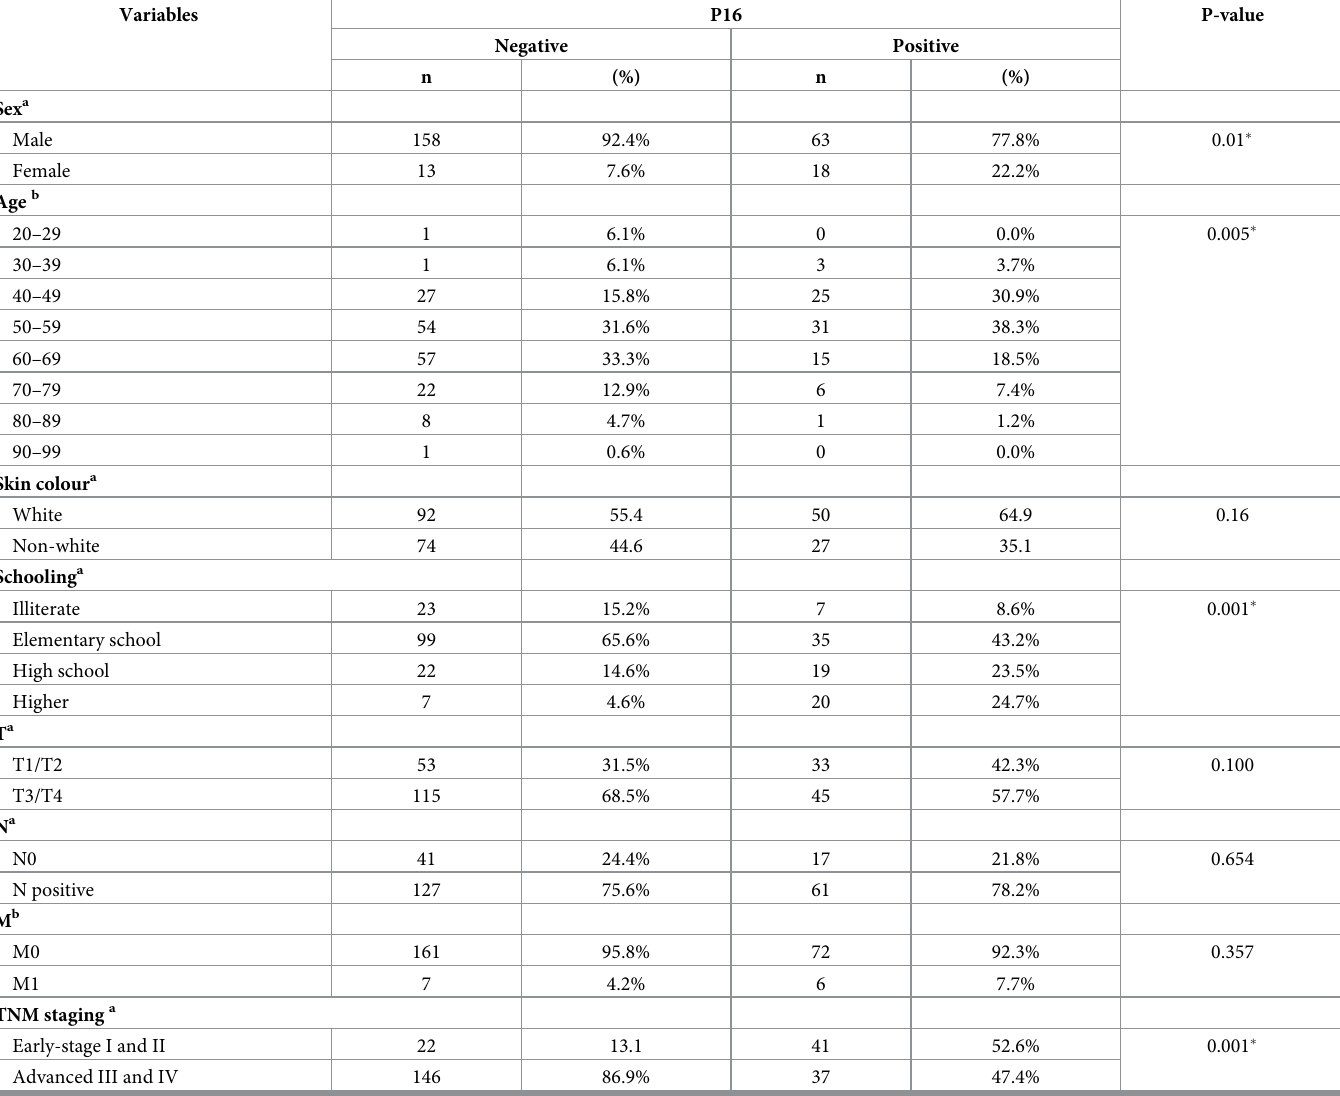
Table 1. Associations of p16 expression with the epidemiological characteristics of the patients.